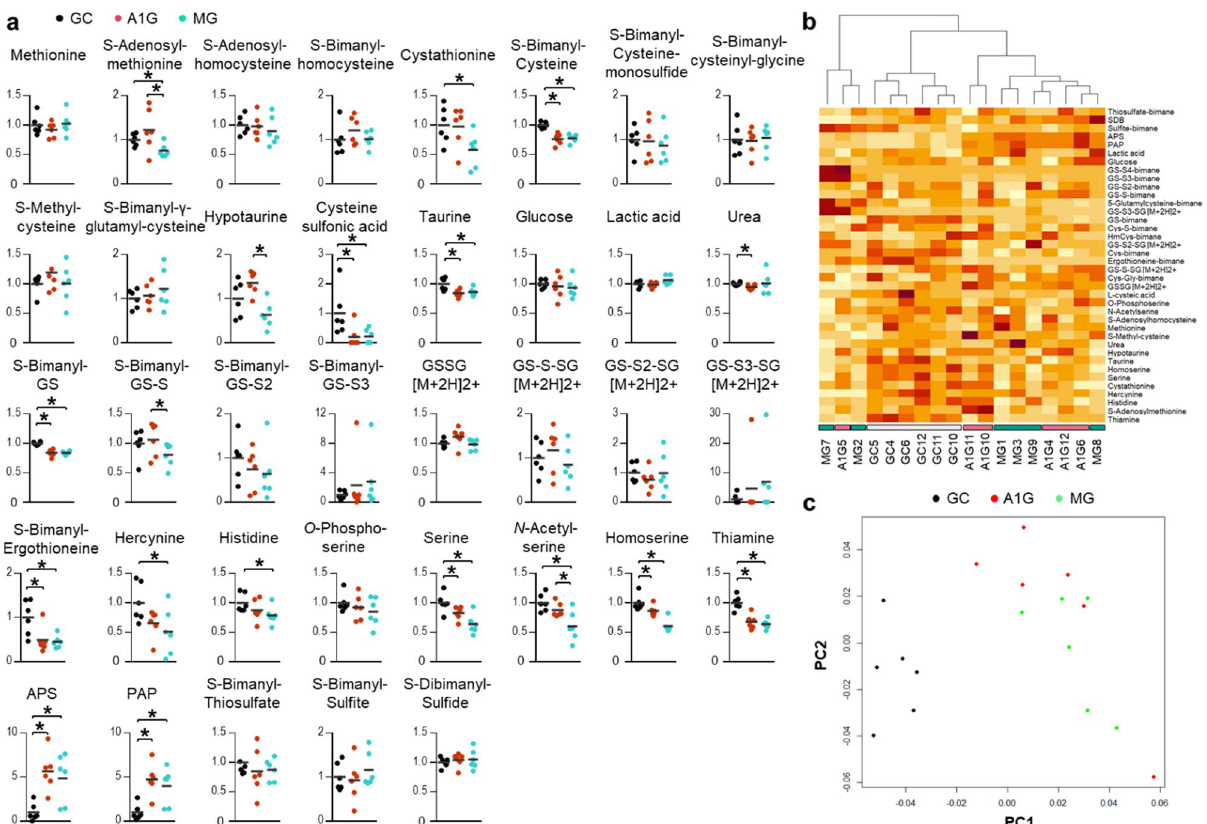
Figure 1.. Measurement of sulfur compounds in the liver. ( a ) Quantification of sulfur compounds in the liver homogenates of control mice on Earth (GC), mice under artificial earth-gravity in space (A1G), and mice under microgravity in space (MG). GS, Glutathione; GSSG, glutathione disulfide; PAP, 3 ′ -phosphoadenosine- 5 ′ -phosphosulfate; APS, adenosine-5 ′ -phosphosulfate. ‘S-Bimanyl-’ indicates that the compounds were detected as bimane-derivates. Each horizontal bar represents the mean. * P < 0.05. Comparisons of parameters were performed with one-way ANOVA followed by Dunnett’s test for multiple comparisons ( n = 6 each). Dot plots were made using GraphPad Prism 6.07 for Windows, GraphPad Software, San Diego, CA USA, www. graph pad. com. ( b ) Heatmap and hierarchical clustering were performed in R. The red color intensity correlates with the relative signal abundance. ( c ) Spatial placement of crowds on a non-metric multidimensional scaling (NMDS) using the Bray index. NMDS analysis, using the “vegan” package in R to analyze similarity indices, was performed on normalized metabolomics data that was subsequently log-transformed and auto-scaled 31,32 . The first two coordinates were plotted. PC principal